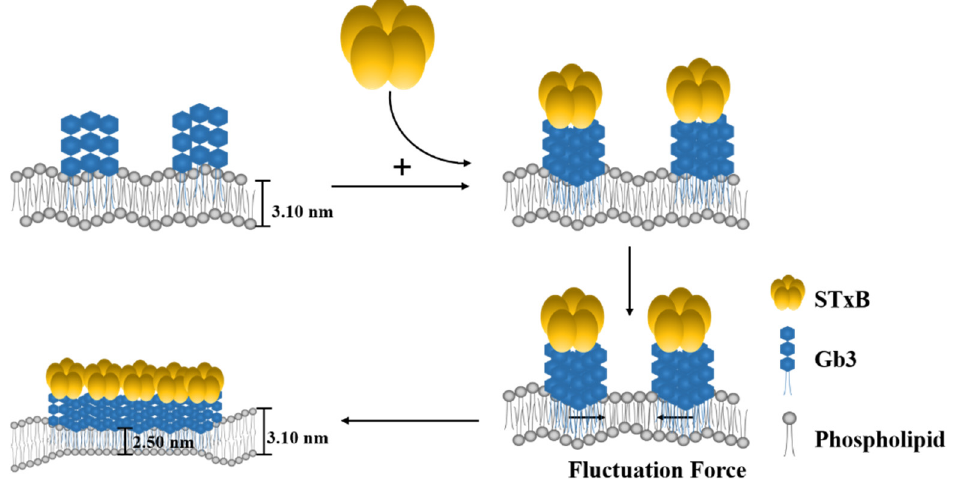
Figure 6. Schematic representation of Shiga toxin B-subunit induced SUV membrane invagination and hypothesis on model membrane surface clustering. (1) For glycolipid Gb3 itself, it can form extremely high density clusters in nanometer size, and it only serves as connector between STxB subunit with membrane surface. (2) Toxin binding can cause inhomogeneous compaction of glycolipid into larger domains and induce the negative curvature on the membrane through toxin-glycolipid clusters to enable changes of membrane